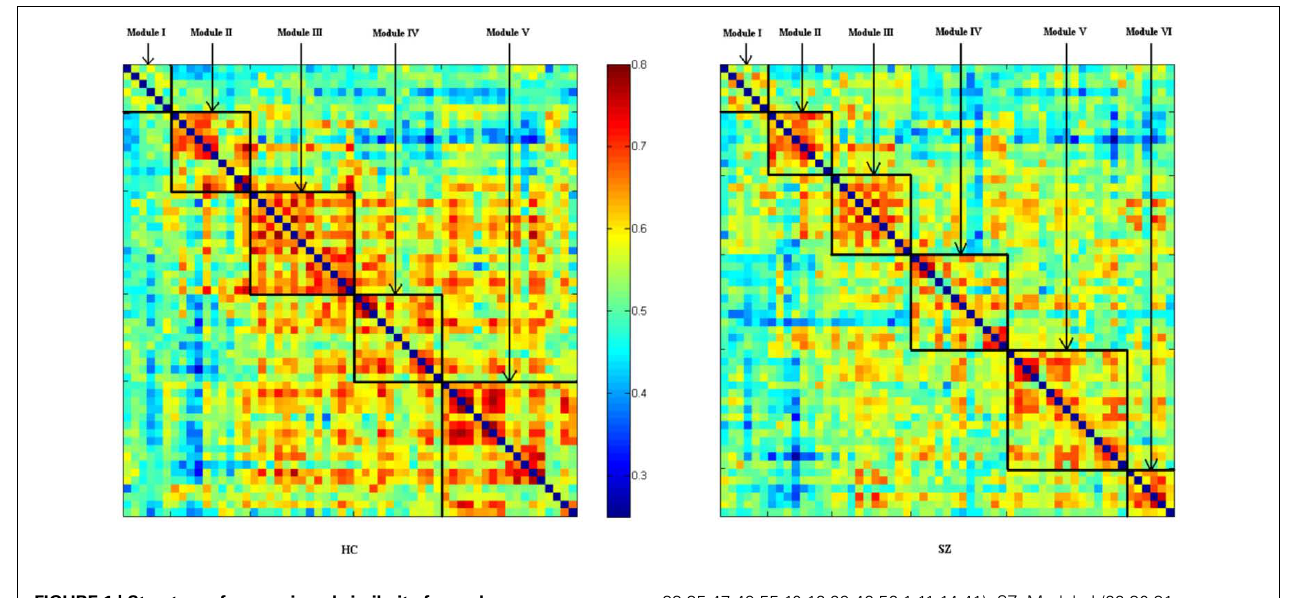
FIGURE 1 | Structure of mean signed similarity for each group after organized by modules. ICs’ index (from top to down; from left to right) is: HC, Module I (22 30 31 36 52 57), Module II (8 13 20 34 50 51 9 37 45 54), Module III (4 21 25 27 39 40 43 53 6 12 15